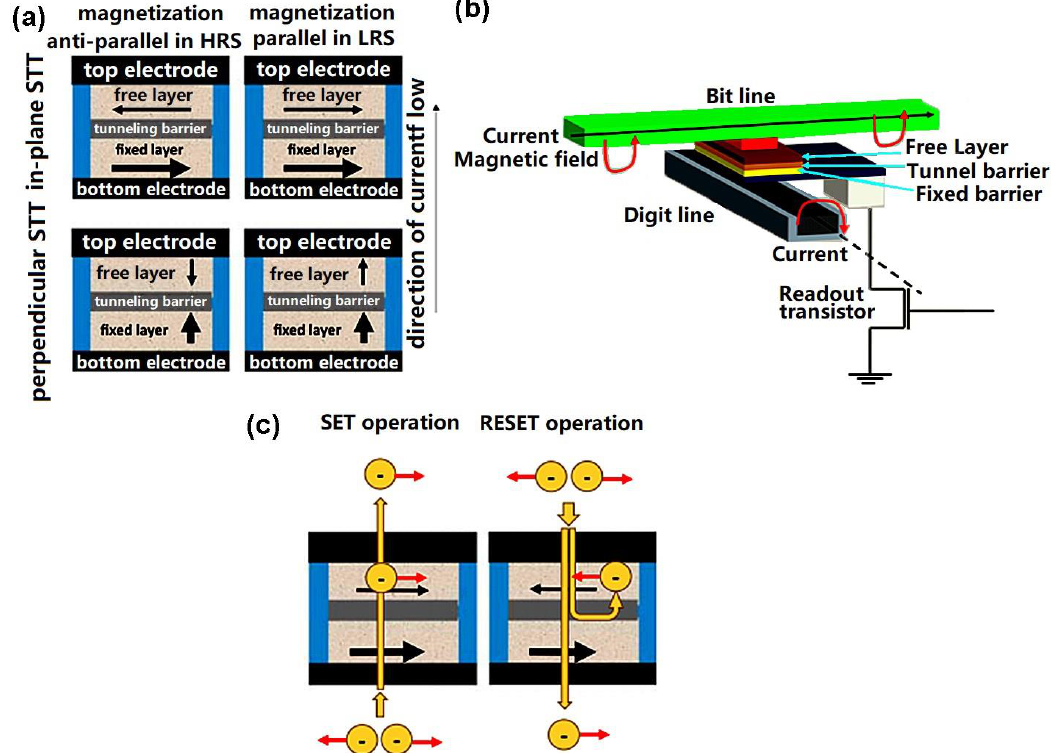
Figure 5. MTJ (magnetic-tunnel junction) and MRAM structure and operation: ( a ) the structure of an MTJ with a tunneling barrier sandwiched between a free layer and a fixed layer; ( b ) the cell architecture of a typical MRAM; ( c ) the ‘set’ (i.e., write) and ‘reset’ (i.e., re-write) operations of MRAM, according to the relative orientation of the magnetization direction of the fixed and free magnetic layers. (( a , c ) are reprinted with permission from [64] and ( b ) is reprinted with permission from [47].)